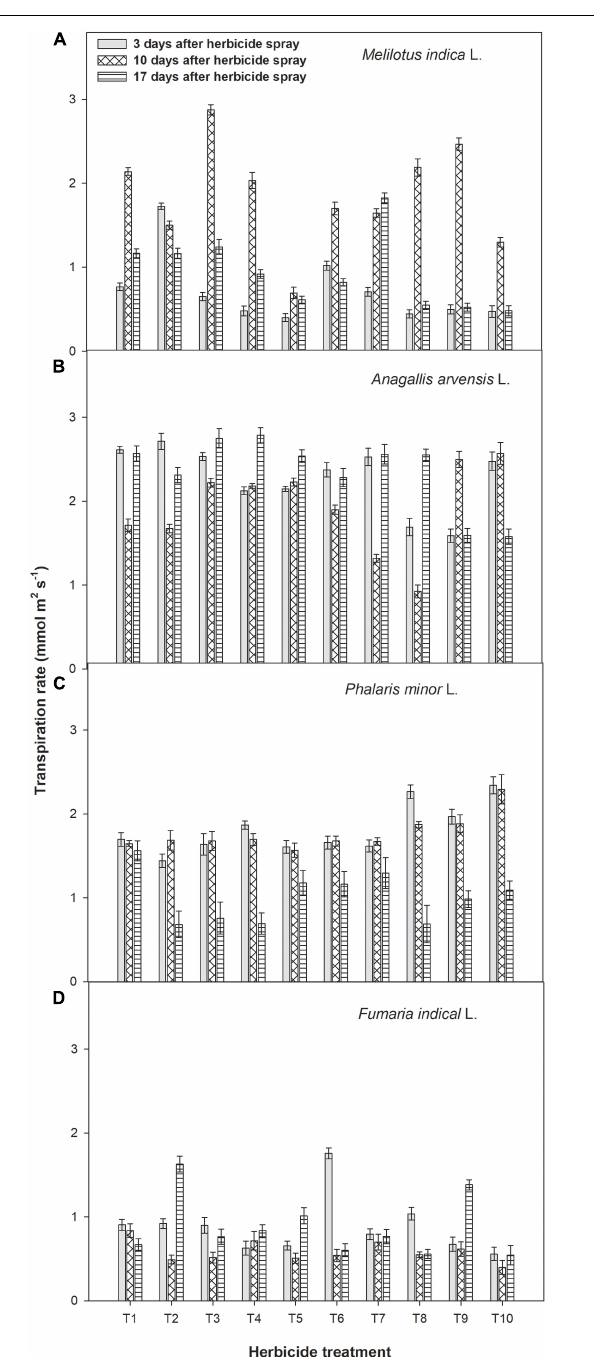
FIGURE 3 | Impact of metribuzin with and without adjuvants on transpiration rate of Melilotus indica L. (A) , Anagallis arvensis L. (B) , Phalaris minor L. (C) , and Fumaria indica L. (D) at 3, 10, and 17 days after herbicide spray (average of 2 years’ data). T 1 , weedy check; T 2 , metribuzin at 175 g a.i. ha − 1 ; T 3 , metribuzin at 140 g a.i. ha − 1 ; T 4 , metribuzin at 105 g a.i. ha − 1 ; T 5 , metribuzin at 175 g a.i. ha − 1 + Ad-500 at 400 ml ha − 1 ; T 6 , metribuzin at 140 g a.i. ha − 1 + Ad-500 at 400 ml ha − 1 ; T 7 , metribuzin at 105 g a.i. ha − 1 + Ad-500 at 400 ml ha − 1 ; T 8 , metribuzin at 175 g a.i. ha − 1 + Bio-power at 400 ml ha − 1 ; T 9 , metribuzin at 140 g a.i. ha − 1 + Bio-power at 400 ml ha − 1 ; T 10 , metribuzin at 105 g a.i. ha − 1 + Bio-power at 400 ml ha − 1 .